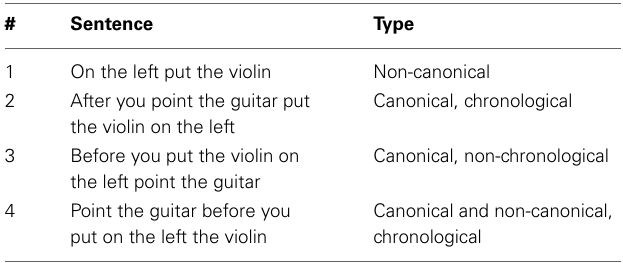
Table 3 | Example of sentences used during testing mode of action performer